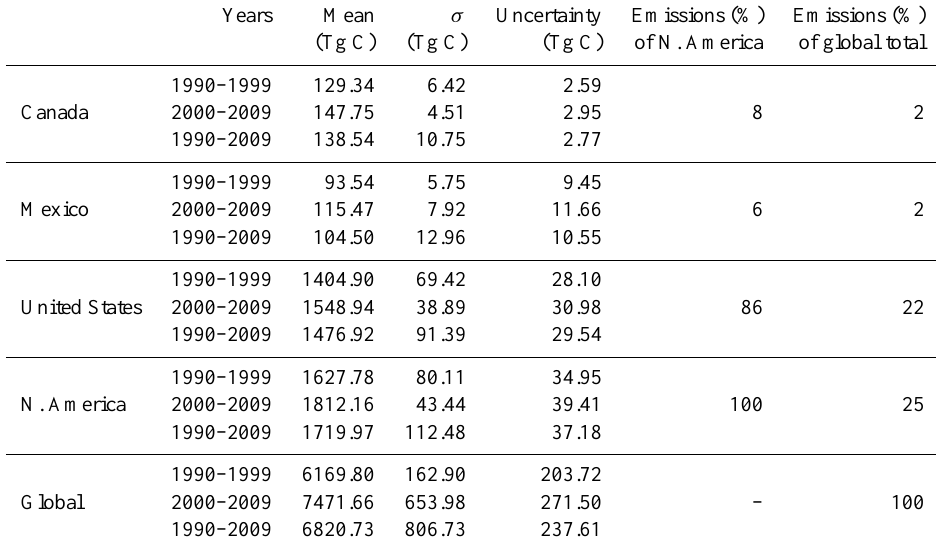
Table 3. Mean, standard deviation, uncertainty and relative percentage of emissions for various political units and years. The standard deviation of the time-averaged mean is indicated by σ . Uncertainty is our best assessment of how well we know the mean, integrating the variability of the data with knowledge of the quality of the data. North America’s percentage of global total does not equal the sum of its components due to rounding. Flux data from Boden et al. (2013); uncertainty estimate from Andres (unpublished data). Years Mean σ Uncertainty of N.